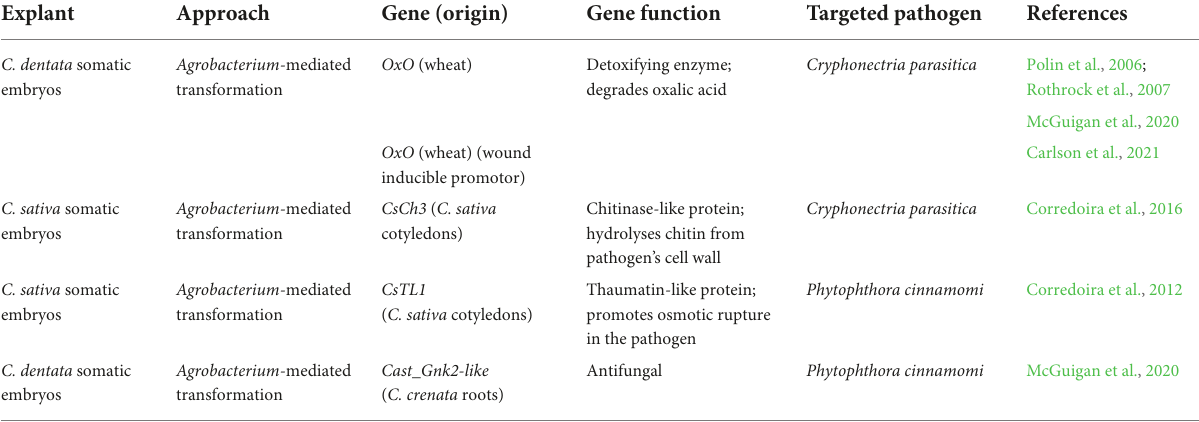
TABLE 3 Genetic transformation studies performed in European and American chestnuts with the goal of developing pathogen control strategies.